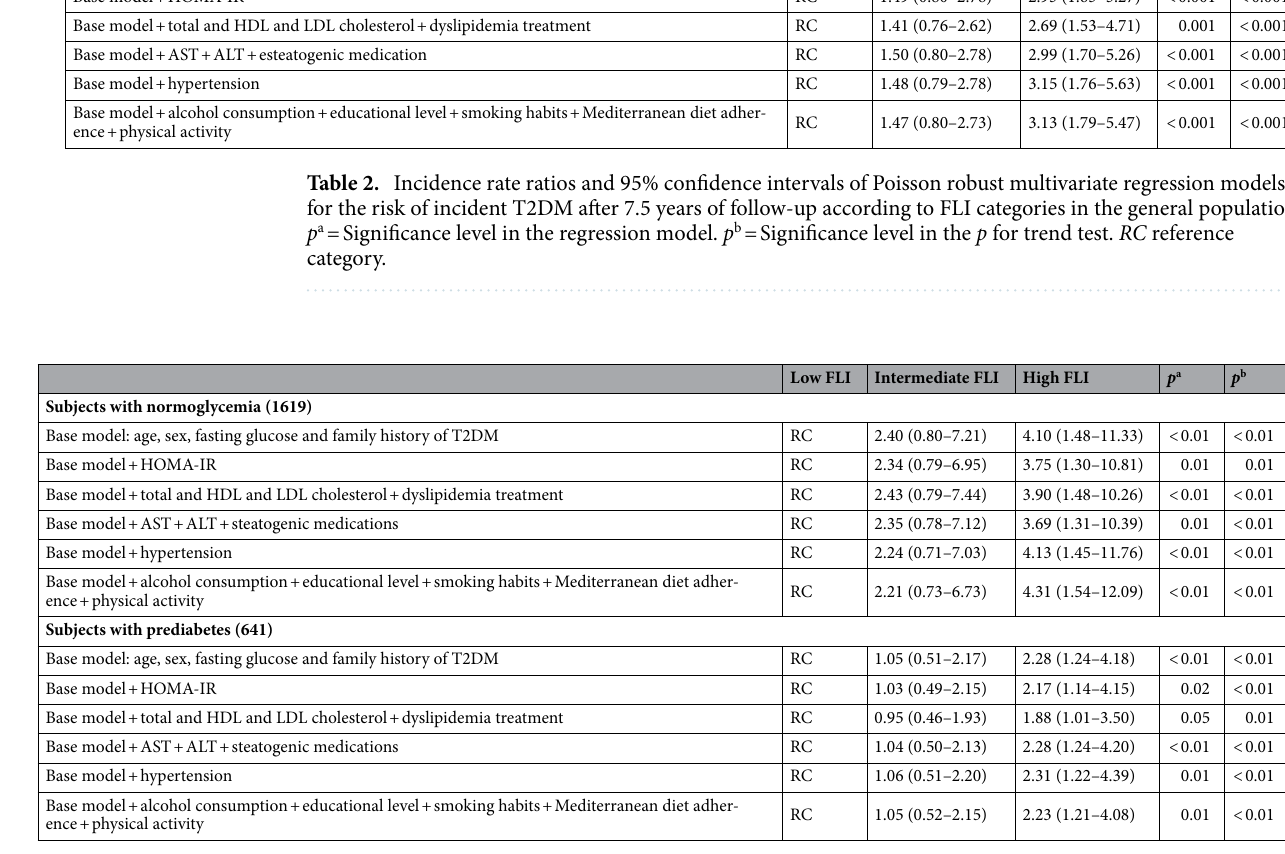
Table 3. Incidence rate ratios and 95% confidence intervals of Poisson robust multivariate regression models for the risk of incident T2DM after 7.5 years of follow-up according to FLI categories and prediabetes status. p a = Significance level in the regression model. p b = Significance level in the p for trend test. RC reference category.